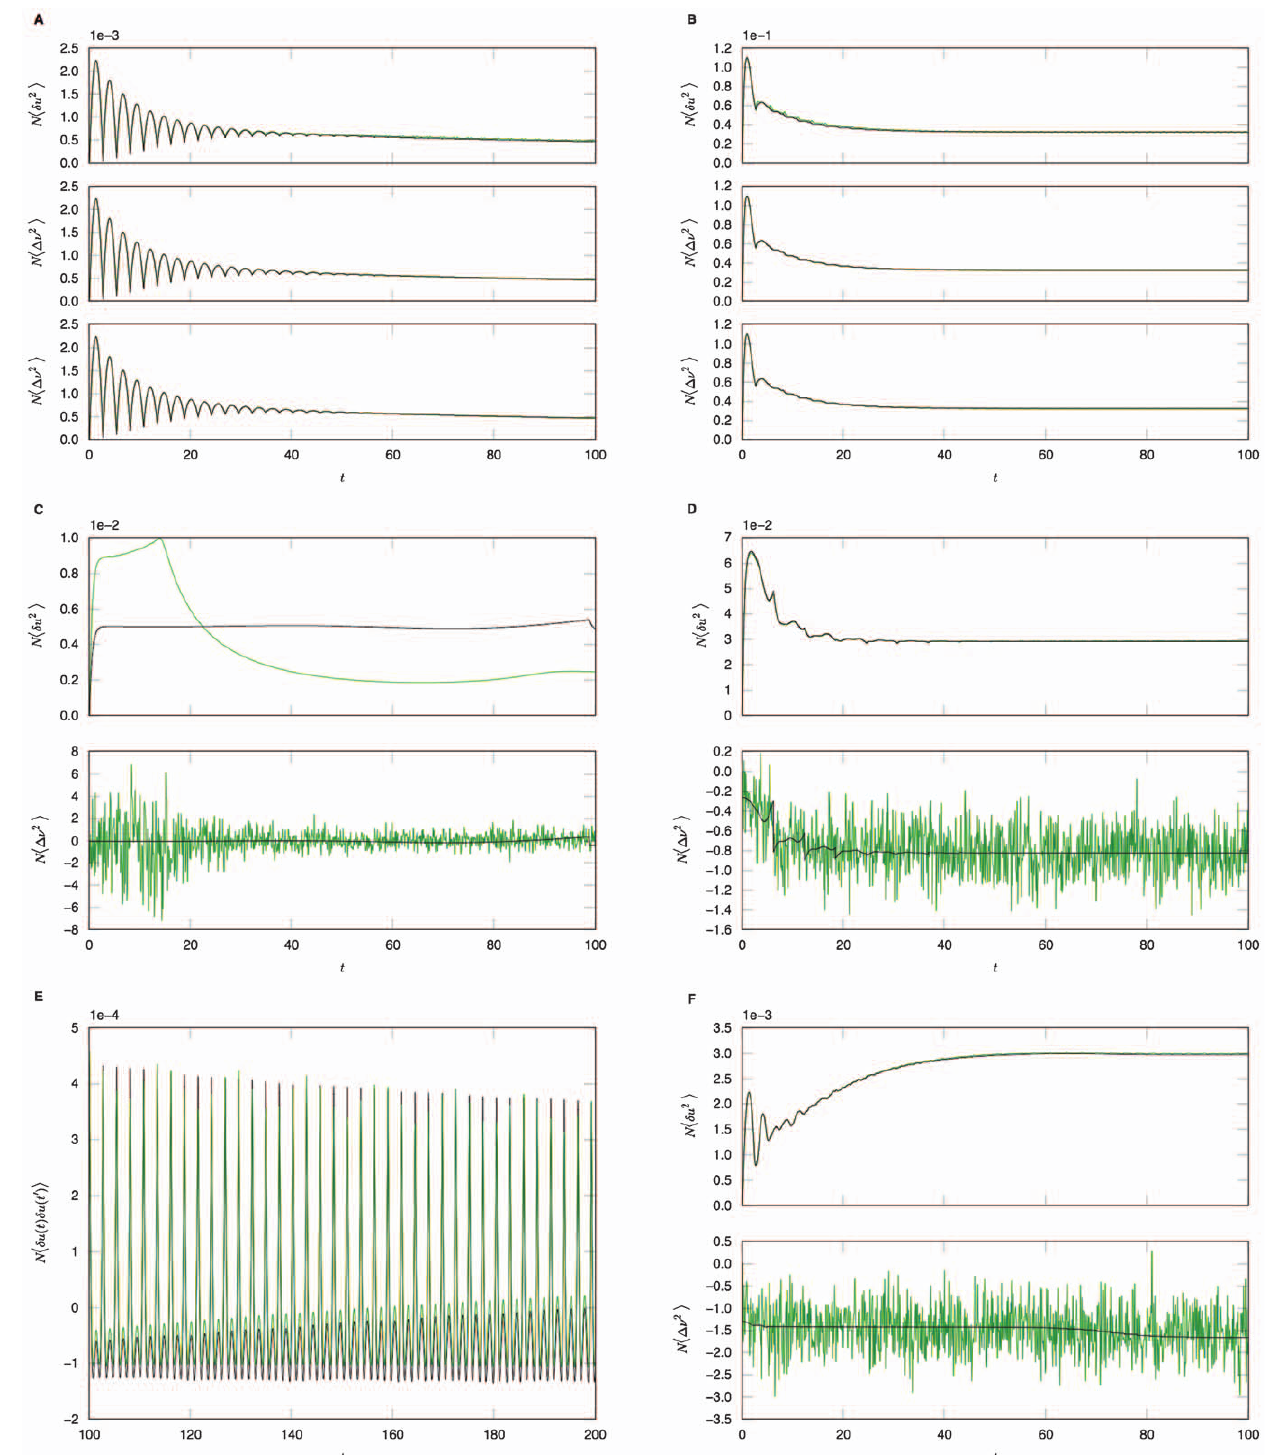
Figure 2. Quadratic integrate-and-fire model. A . Numerical computations (green line) and analytical predictions (black line) for N S d u ( t ) 2 T for I ~ 1 : 0 , b ~ 0 : 1 , a ~ 1 : 0 for N ~ 10 (top), N ~ 100 (middle), N ~ 1000 (bottom) neurons. B . Numerical computations (green line) and analytical predictions (black line) for N S d u ( t ) 2 T for I ~ 0 , b ~ 1 : 0 , a ~ 0 : 1 for N ~ 10 (top), N ~ 100 (middle), N ~ 1000 (bottom) neurons. C . Numerical computations (green line) and analytical predictions (black line) for N S d u ( t ) 2 T (top) and N S D n 2 ( t ) T (bottom) for I ~ 0 , b ~ 1 : 0 , a ~ 1 : 0 , N ~ 1000 . D . N S d u ( t ) 2 T (top) and N S D n 2 ( t ) T (bottom) for I ~ 0 : 1 , b ~ 1 : 0 , a ~ 1 : 0 , N ~ 1000 , where the Poisson contribution has been subtracted. E . Two-time correlator N S d u ( t ) d u ( t ’ ~ 100) T for I ~ 1 : 0 , b ~ 0 : 1 , a ~ 1 : 0 , and N ~ 100 . F Equal time correlators in a heterogeneous network; N S d u ( t ) 2 T and N S D n 2 T for (cid:2) II ~ 1 : 0 , b ~ 0 : 1 , a ~ 1 : 0 and N ~ 100 . I is taken from the interval ½ 0 : 5,1 : 5) for each neuron. Ensemble average for all simulations are taken over 1024000 samples.